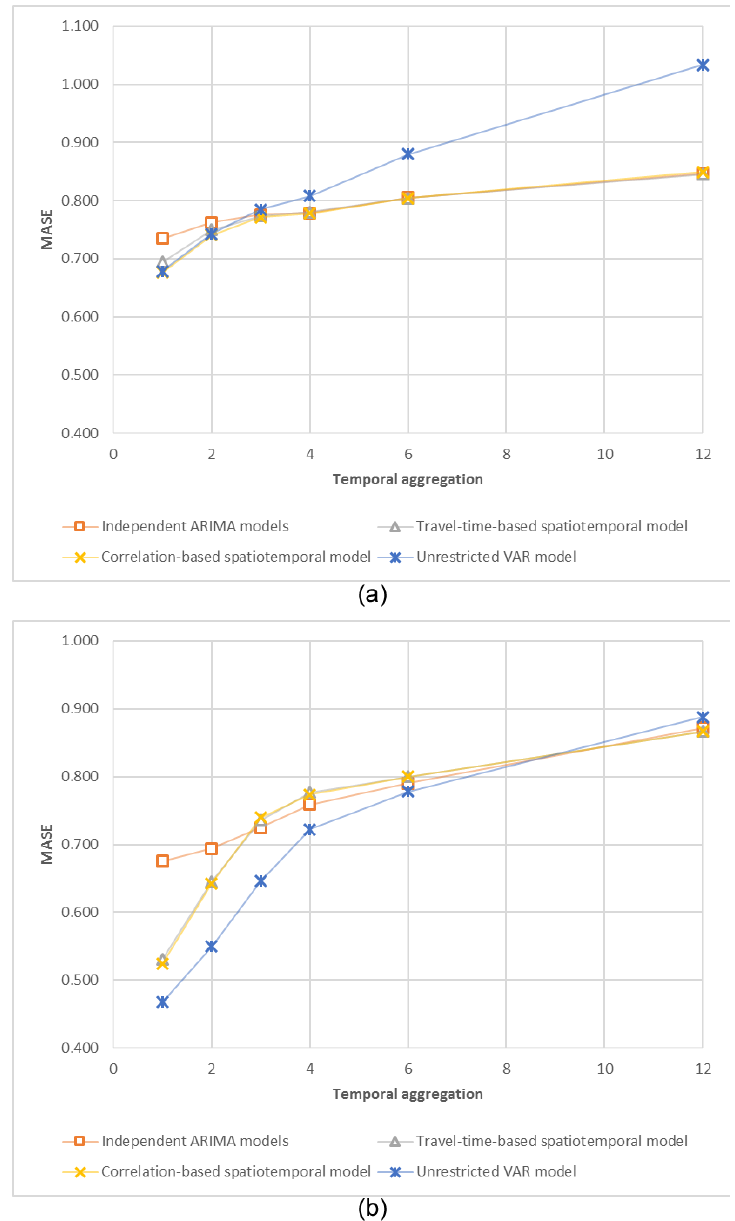
Figure 4. MASE values for one-step ahead forecasts for different temporal aggregation levels: ( a ) detrended traffic volume, the complex spatial structure, ( b ) detrended traffic volume, the sequential spatial structure.